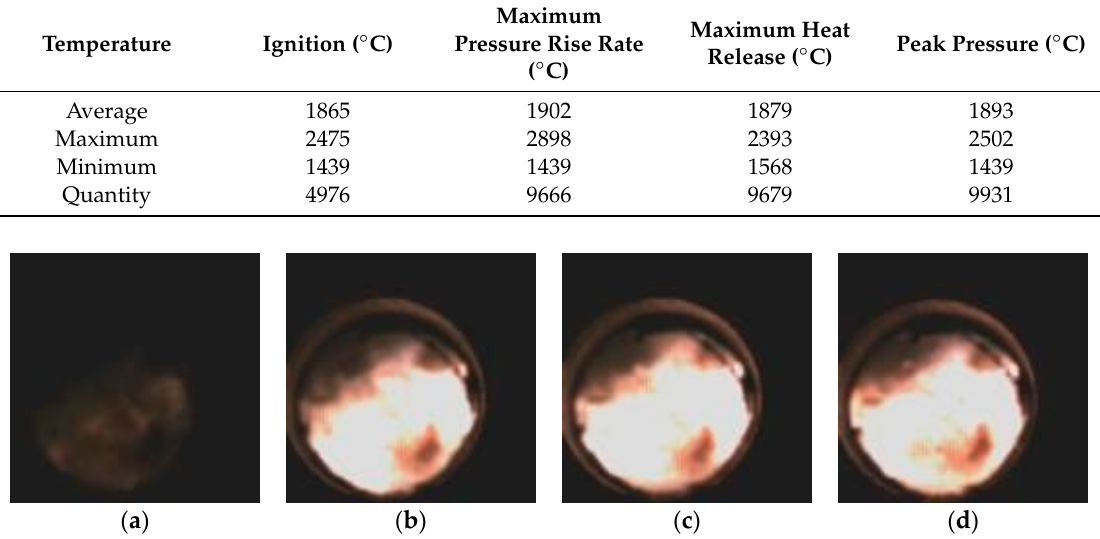
Figure 4. Flame image of series 2. ( a ) Ignition moment; ( b ) maximum pressure rise rate; ( c ) maximum heat release; ( d ) the highest pressure.